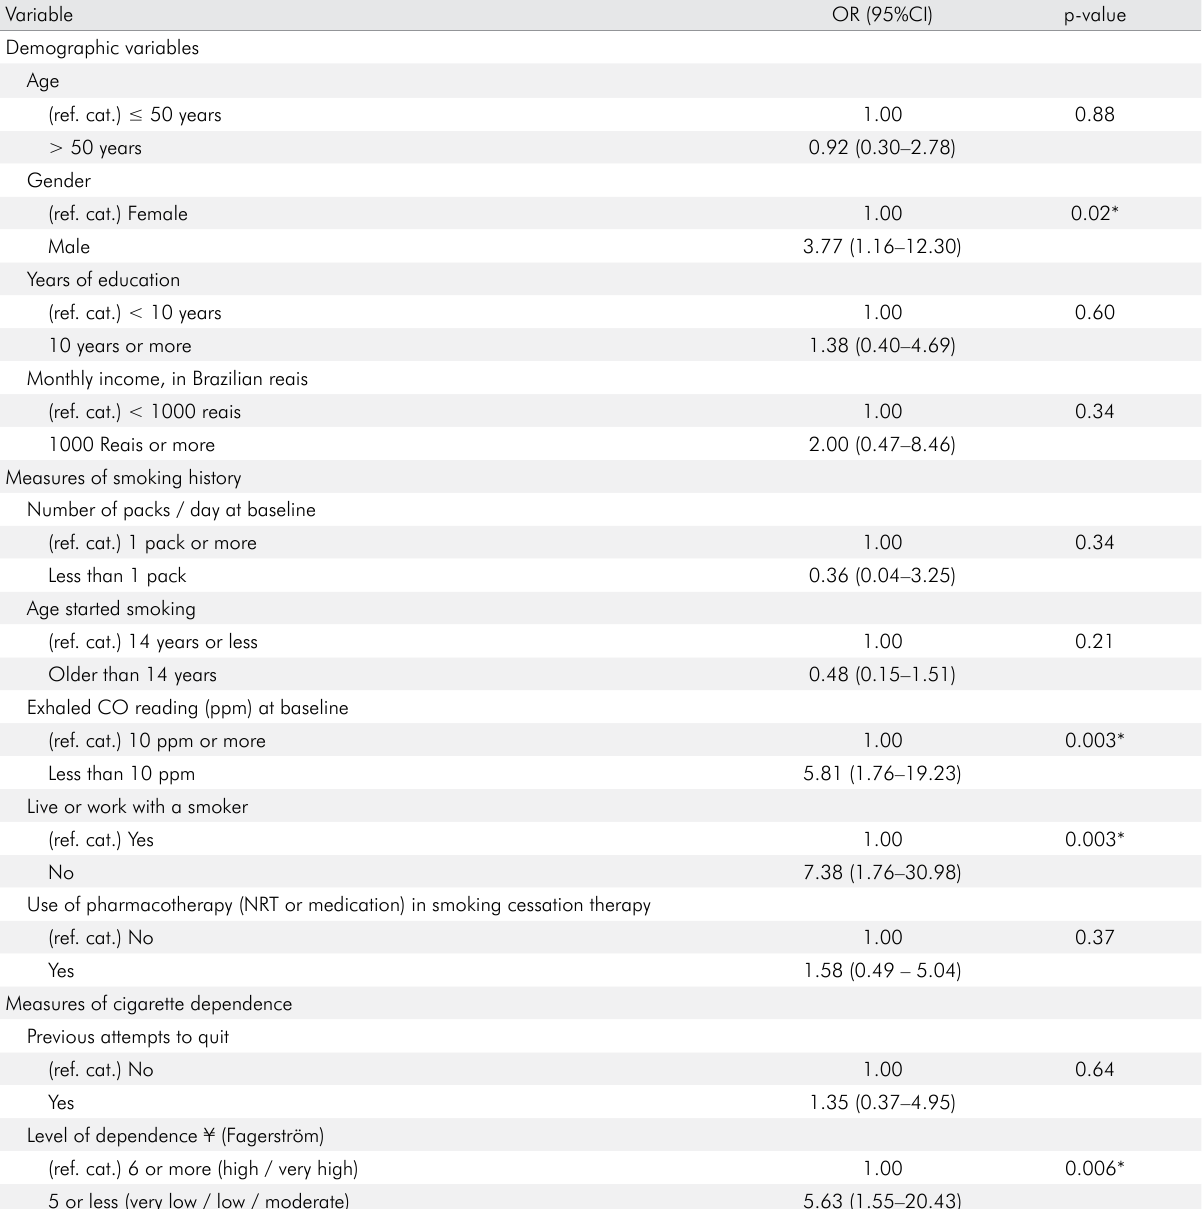
Table 3. Predictors related to smoking cessation among the 18 quitters and 43 non-quitters who remained up to the 24-month examination: univariate